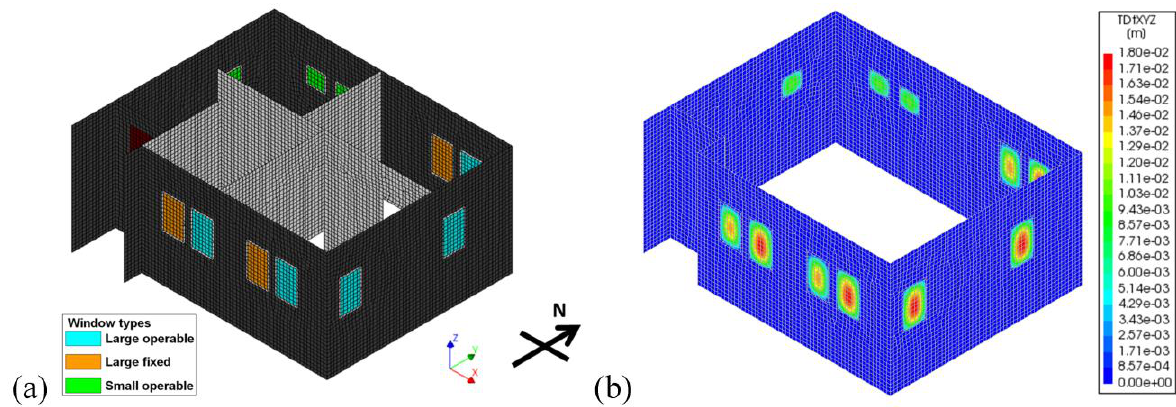
Figure 8. Hydrodynamic analysis of the prototype building: ( a ) numerical model and ( b ) deformation distribution contours at the 3-m water depth.